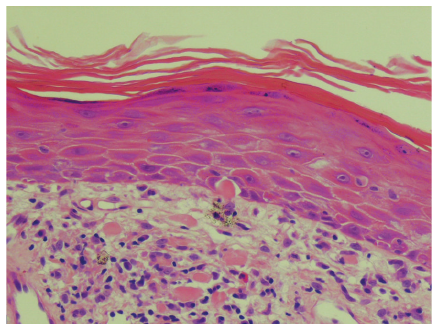
Figure 3: Umbilical 4mm punch biopsy magnification × 200, Hematoxylin and Eosin stain. Features described in